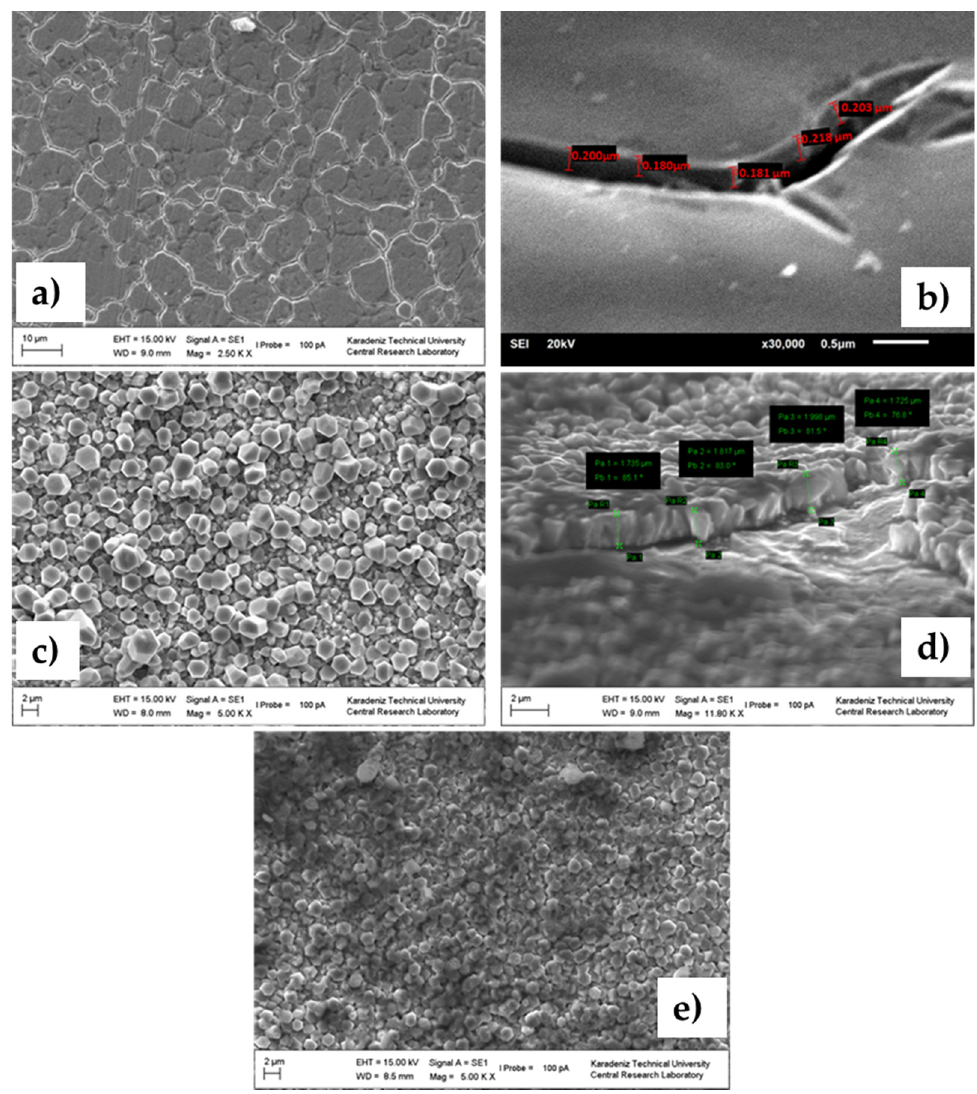
Figure 4. ( a ) Top view and ( b ) 60° tilted SEM images of TiO 2 thin film, ( c ) top view and ( d ) 60° tilted SEM pictures of TiO 2 /ZnO bilayer structure, ( e ) top view SEM image of TiO 2 /ZnO/CuPc heterostructure grown on stainless steel substrates.